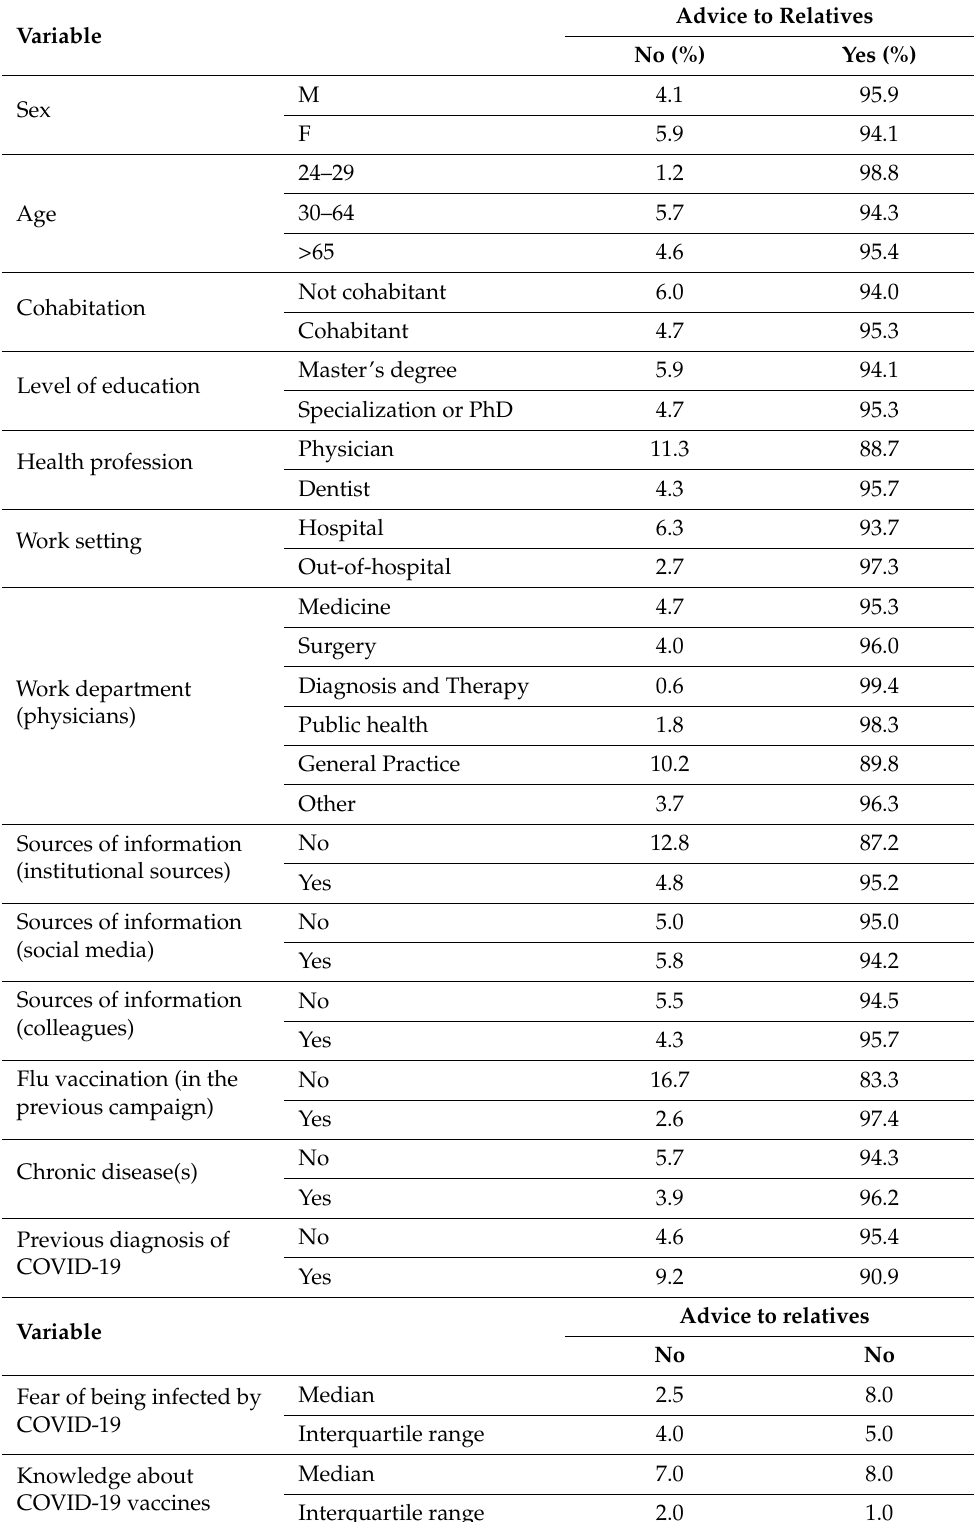
Table 4. Descriptive analysis of the distribution of respondents according to their tendency to recommend vaccination to